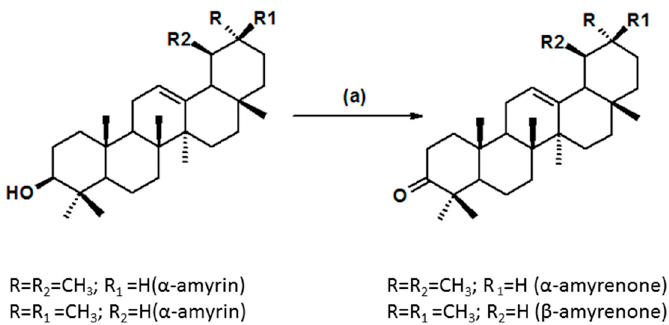
Figure 1. The synthesis of oxidized derivatives of a mixture of α -amyrin (R 1 = H, R 2 = CH 3 ) and β -amyrin (R 1 = CH 3 , R 2 = H). (a) Pyridinium-chlorochromate (CCP), CH 2 Cl 2